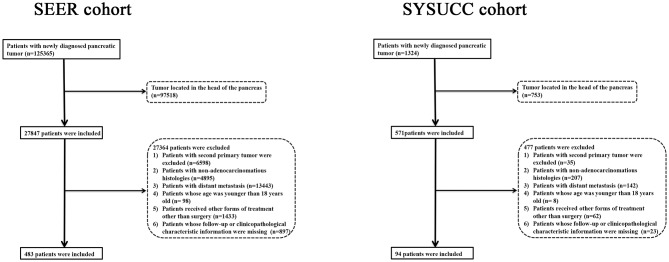
The flow diagram of the selection process for the study cohort.